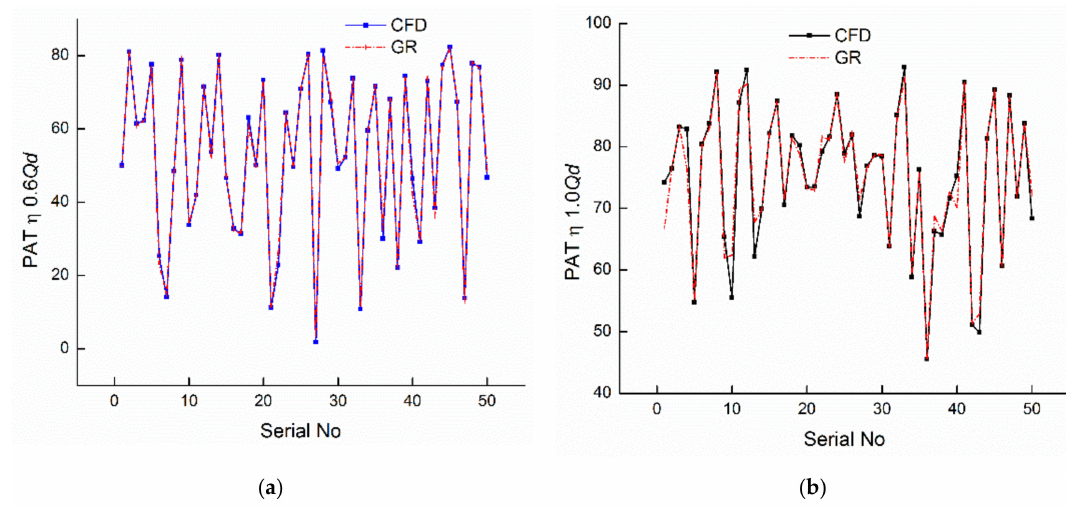
Figure 14. R-Square analysis of PAT e ffi ciency: ( a ) 0.6 Q d , ( b ) 1.0 Q d, and ( c ) 1.4 Q d.